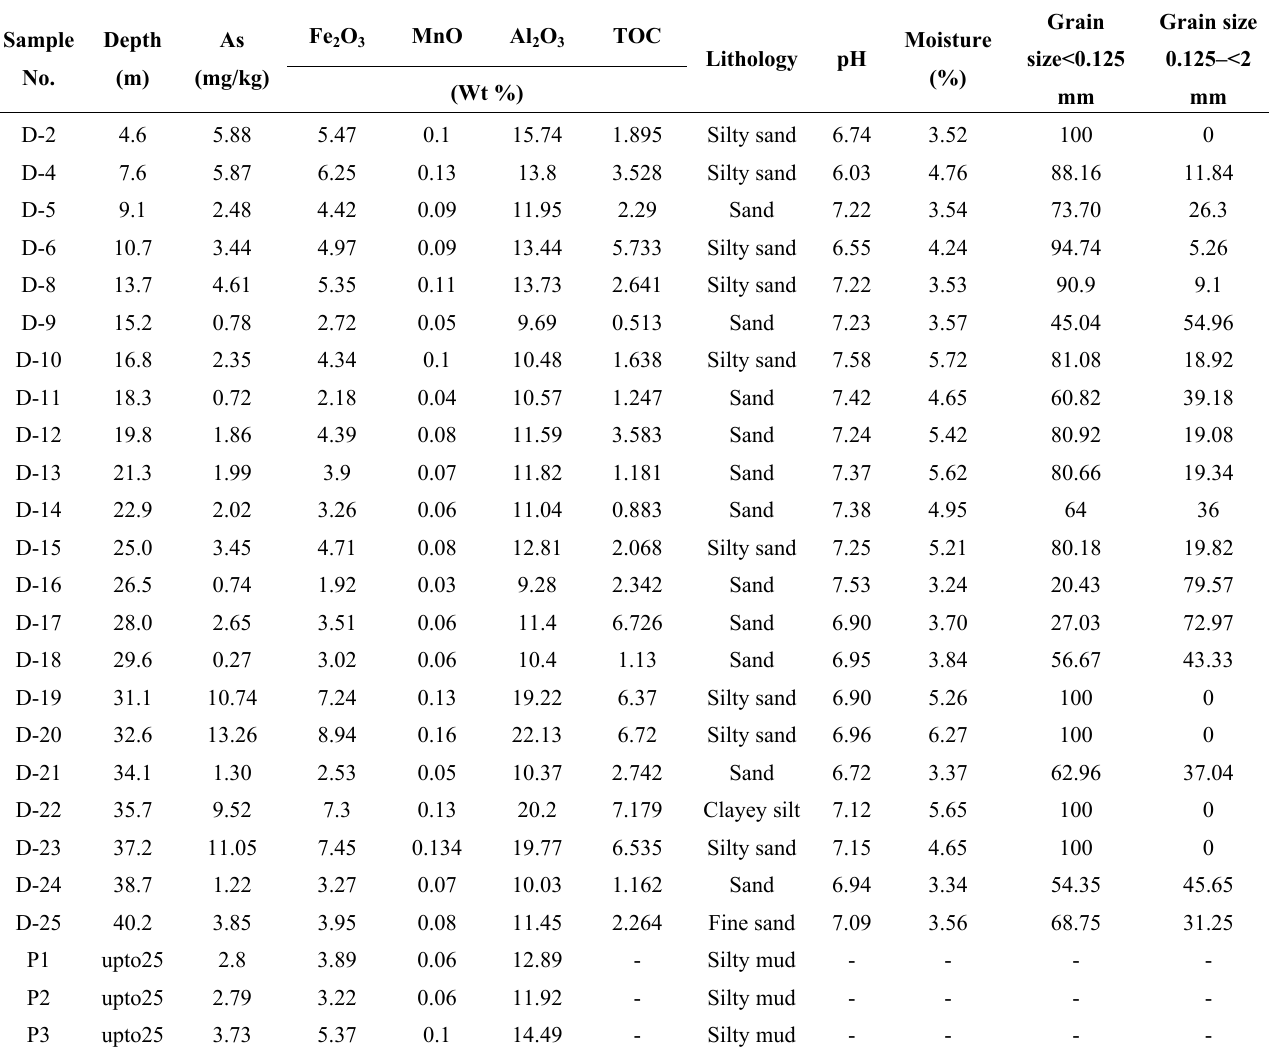
Table 2. Content of As, Fe, Mn and Al oxides, along with lithological characteristics, pH, moisture content and grain size distributions (%) of cores, pond and paddy soils from